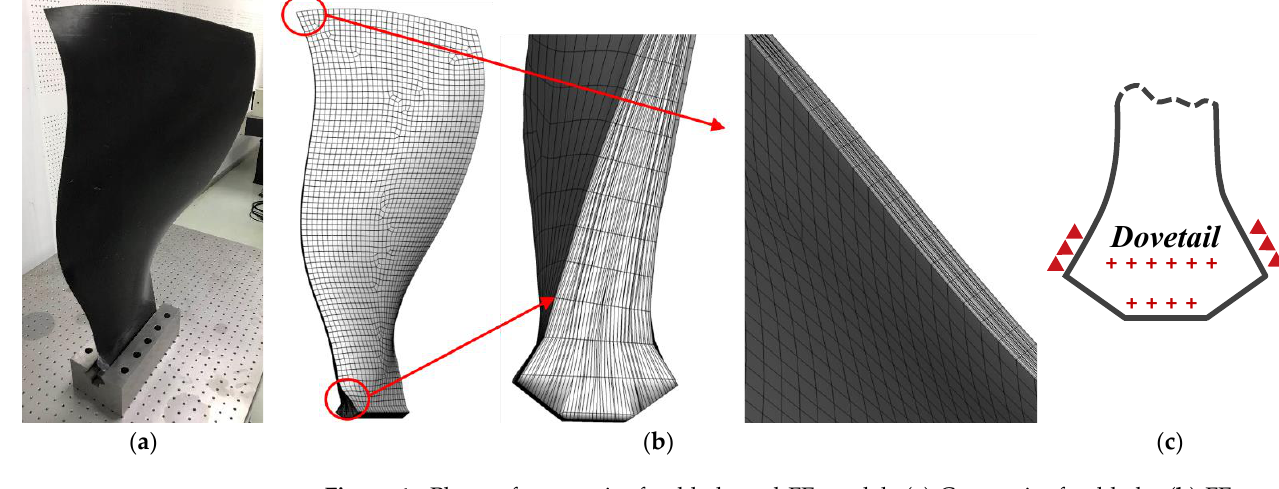
Figure 1. Photo of composite fan blade and FE model: ( a ) Composite fan blade; ( b ) FE model; ( c ) Boundary conditions.